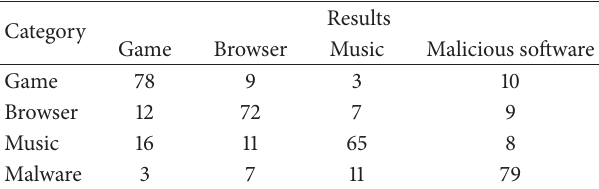
Table 1: Typical applications results.